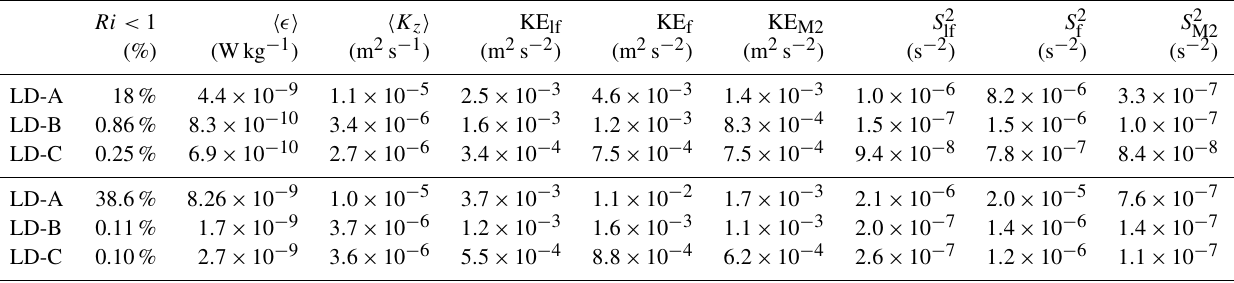
Table 3. Statistics at the long-duration stations: percentage of N 2 − S 2 < 0 (i.e., Ri < 1), median values of (cid:15) , K z , mean value of kinetic energy for the sub-inertial frequencies, inertial frequency and semi-diurnal M2 tidal constituent, and the same for shear variance. The average is performed over a 100–500m surface layer (first three lines) as well as over a 50–250m layer to highlight the impact of the niw at LD-A.